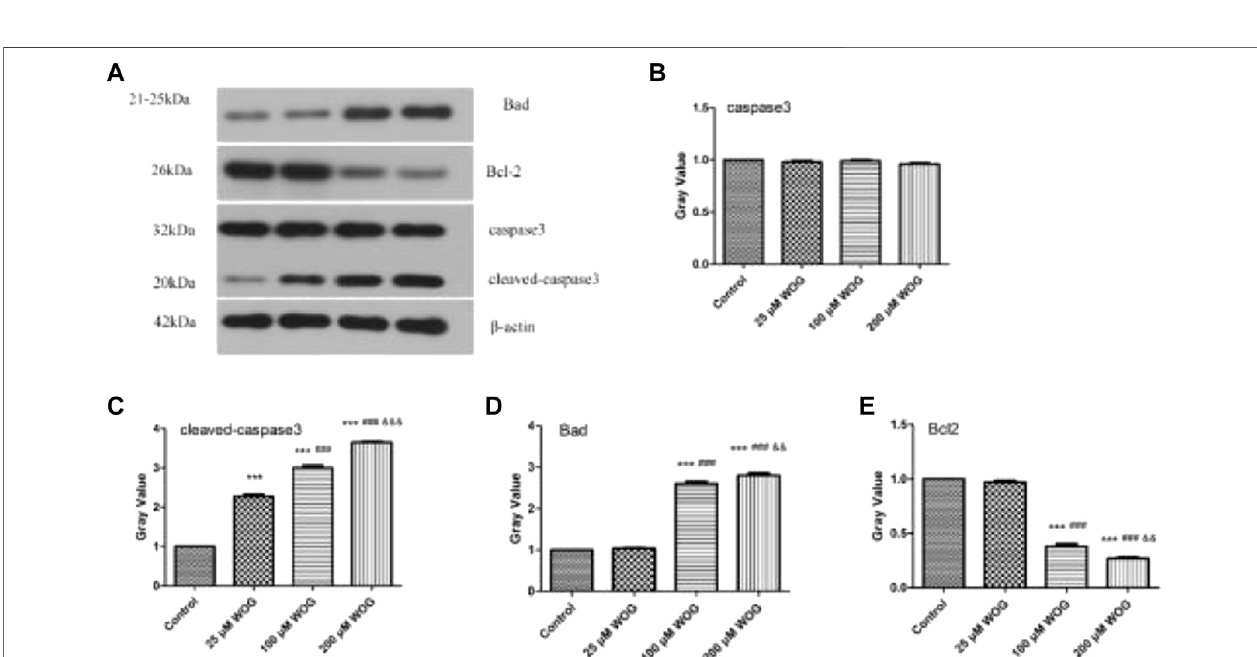
FIGURE 7 | The expression of caspase-3/cleaved-caspase-3, Bad, and Bcl-2 proteins was inhibited by Wogonin in U251 cells (A) Western blot analysis (B – E) Gray analysis.